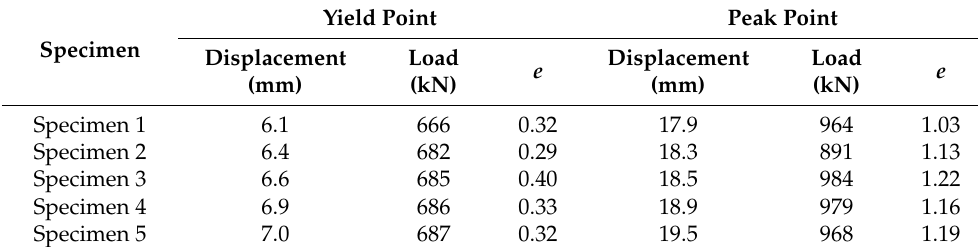
Table 3. Energy dissipation coefficients of the five specimens.